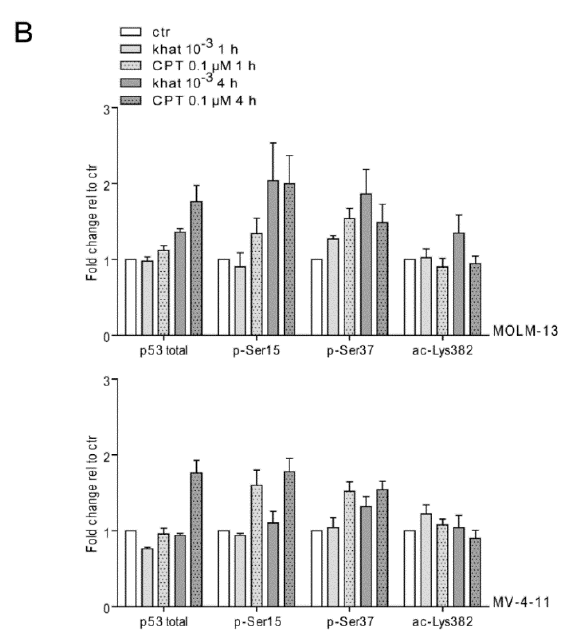
Figure 3. Khat induced p53 phosphorylation and acetylation in MOLM-13 and MV-4-11. ( A ) MOLM-13 and MV-4-11 were exposed to khat-extract dilutions of 10 –3 , 3.16 × 10 –4 and 10 –4 , and to 0.1 µ M CPT. Alterations in levels of total p53 and p53 phosphorylated at serine 15 and acetylated at lysine 382 were evaluated after 1 and 4 h by 1D-PAGE and Western blotting techniques (original blots can be found at Figure S3). β -actin was used as loading control. The intensity of each band was evaluated using the ImageJ software, and are presented as a ratio: [(intensity of treated sample) / (intensity of control sample)] × 100. ( B ) MOLM-13 and MV-4-11 were exposed a khat-extract dilution of 10 –3 and 0.1 µ M CPT for 1 h before flow cytometric analysis of total p53, p53 phosphorylated at serine 15, serine 37 and acetylated at lysine 382. Results are given as % of control in median fluorescence intensity.